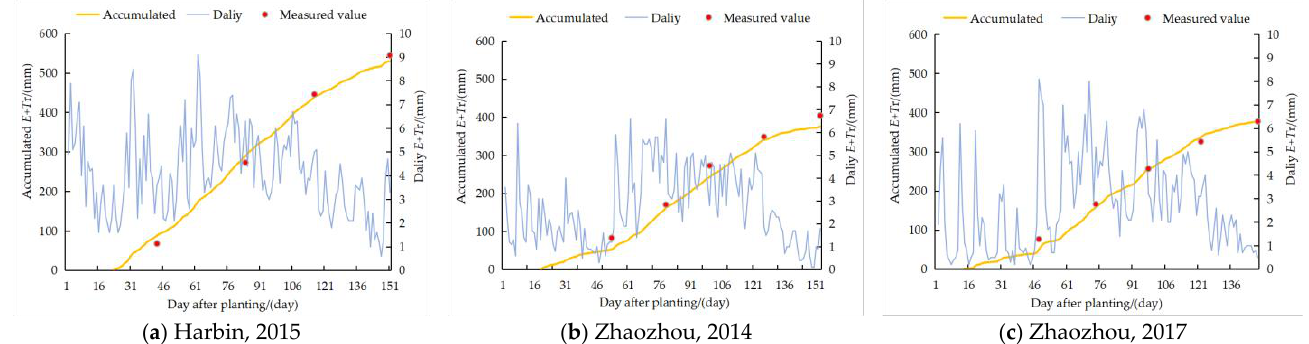
Figure 3. Simulated and measured accumulated ET c ( E + T r ) and ET a ( E + T r ) from model verification during the growing seasons in ( a ) Harbin (2015), ( b ) Zhaozhou (2014), and ( c ) Zhaozhou (2017).